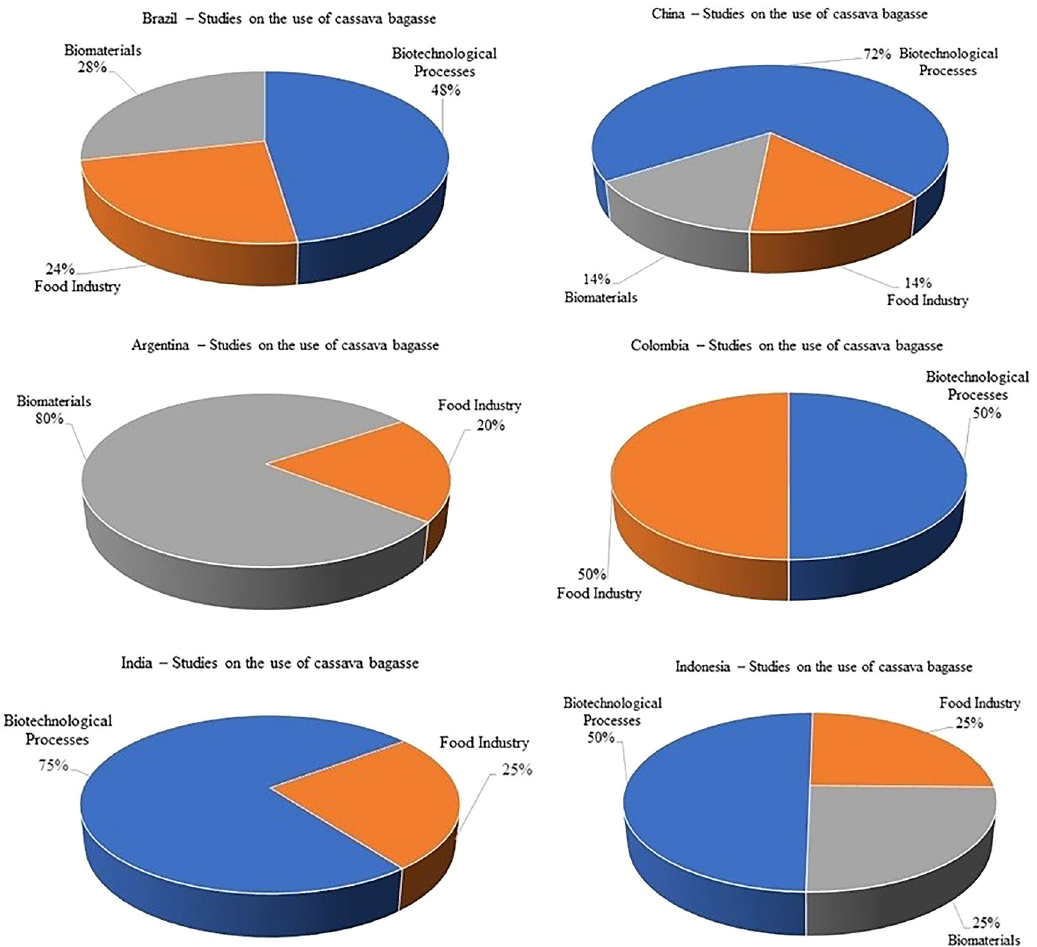
Figure 3. Field of research application of cassava bagasse by